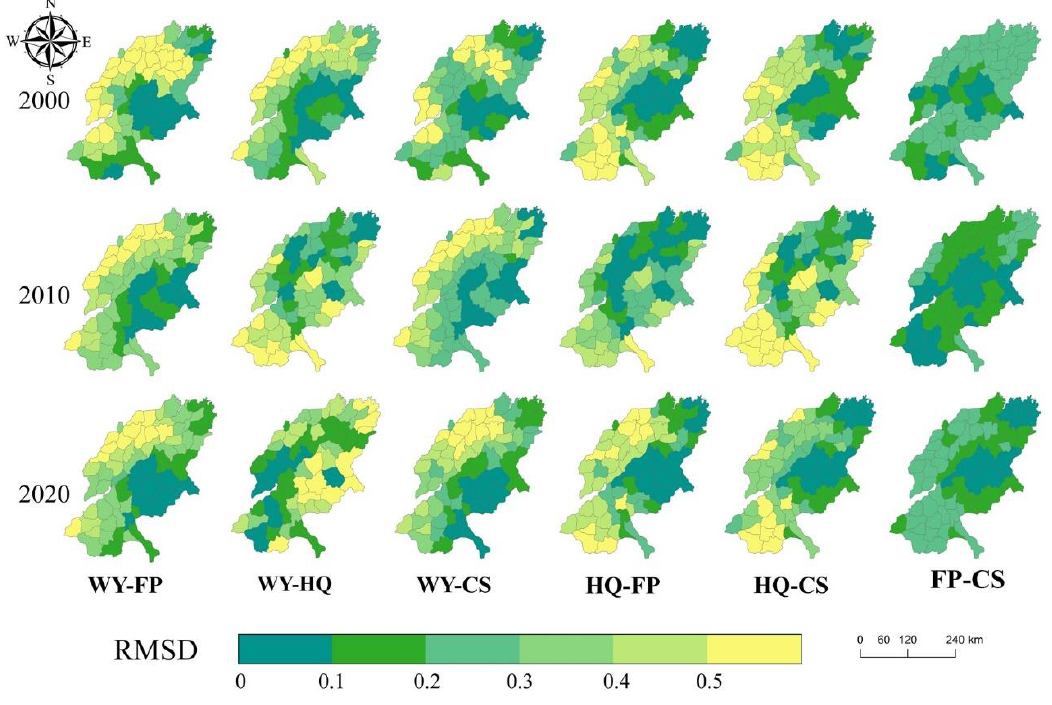
Figure 5. Spatial distribution of the intensity of ecosystem service trade-offs in SYRB.